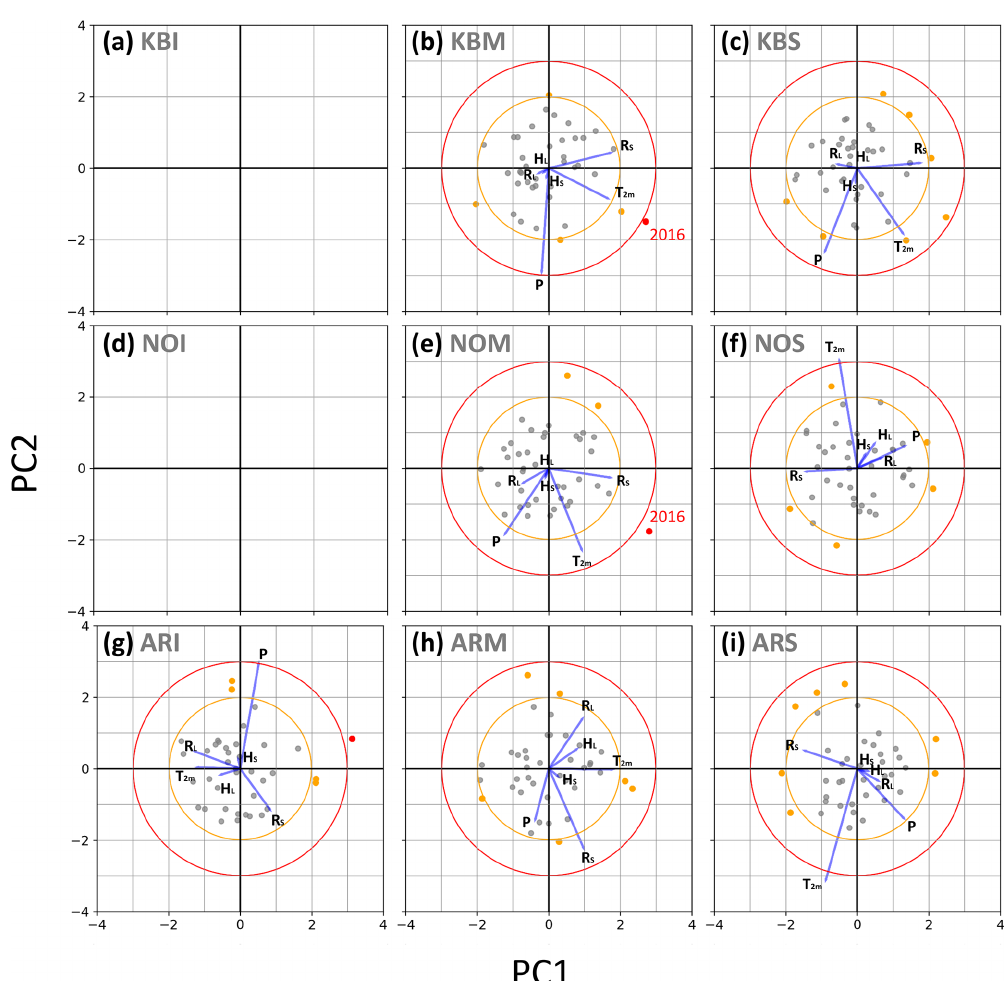
Figure 8. Same as Fig. 7 but for JJA. No biplots are shown for the sub-regions KBI and NOI, because they fall below the minimum size threshold of 10 5 km 2 in summer. The extreme summer 2016 is labeled in panels (b) and (e) due to its role in the preconditioning of the extreme winter 2016/17 (see Sect.